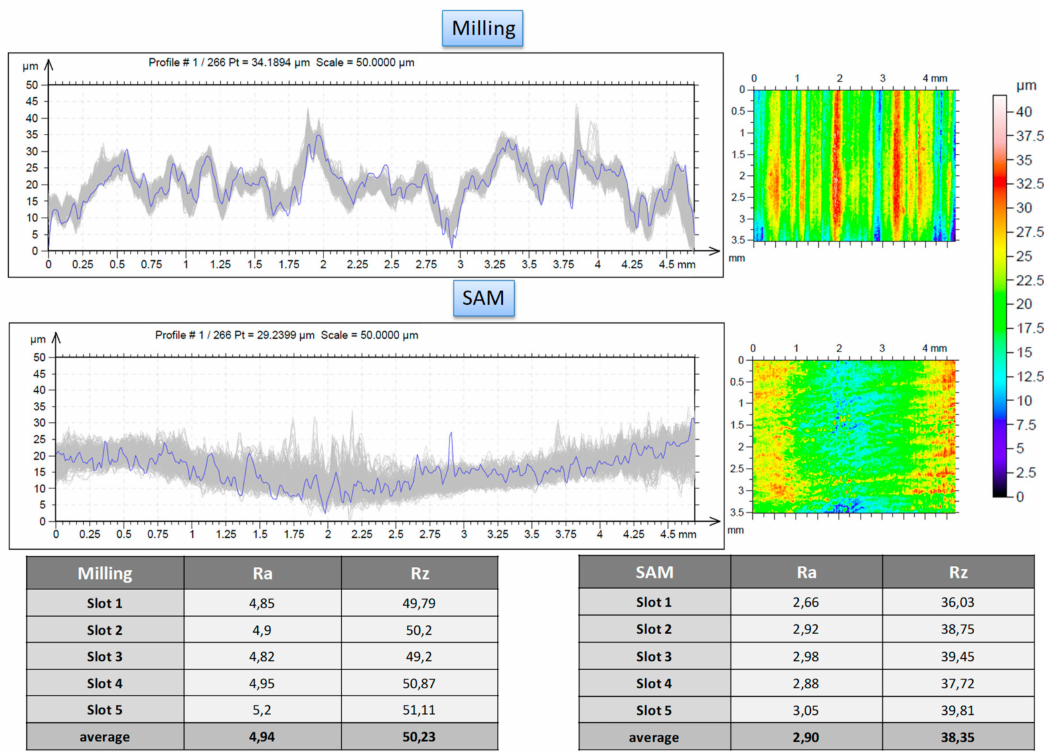
Figure 5. Roughness values (R a and R z ) for flank milling and flank